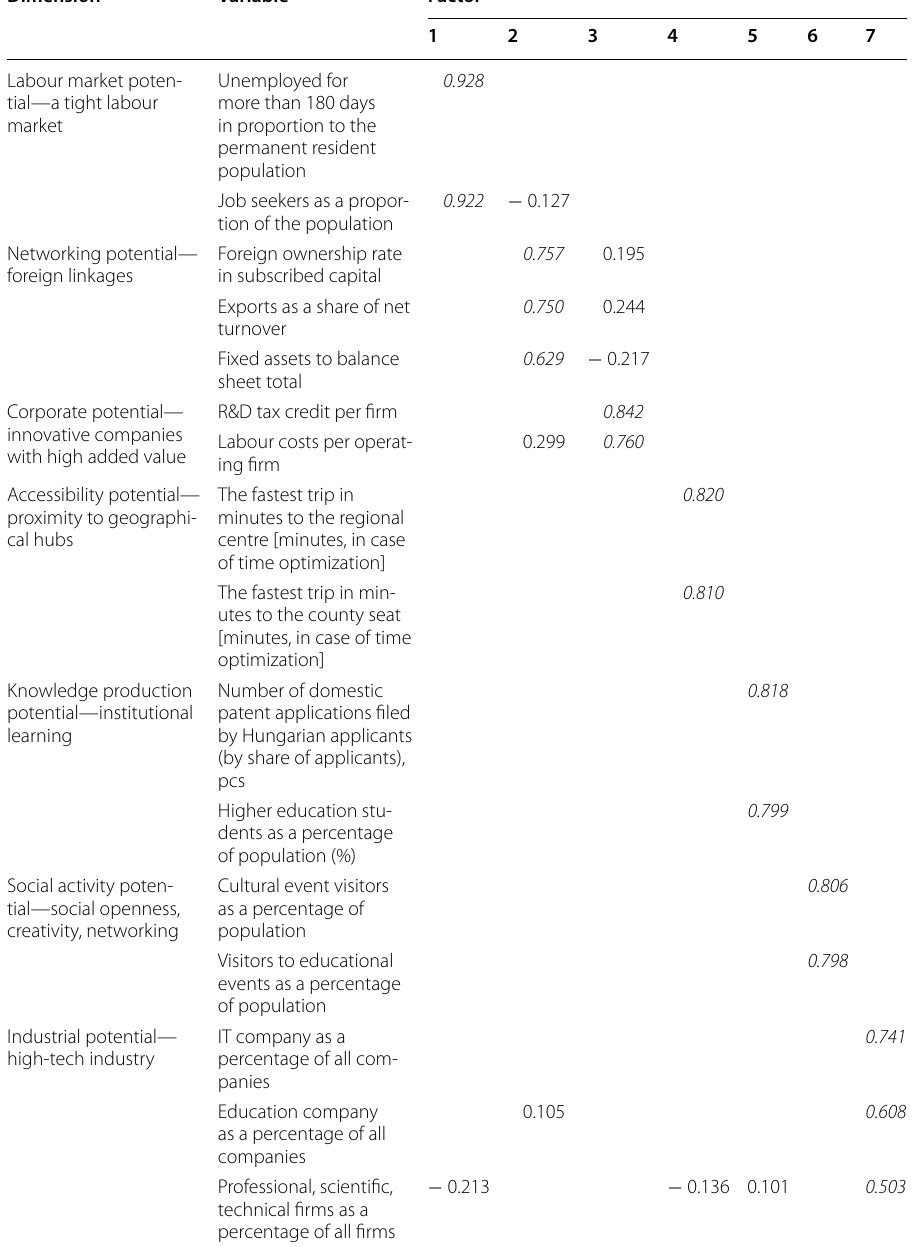
Table 4 Groups of variables serving as the basis of the indexation of spatial innovation